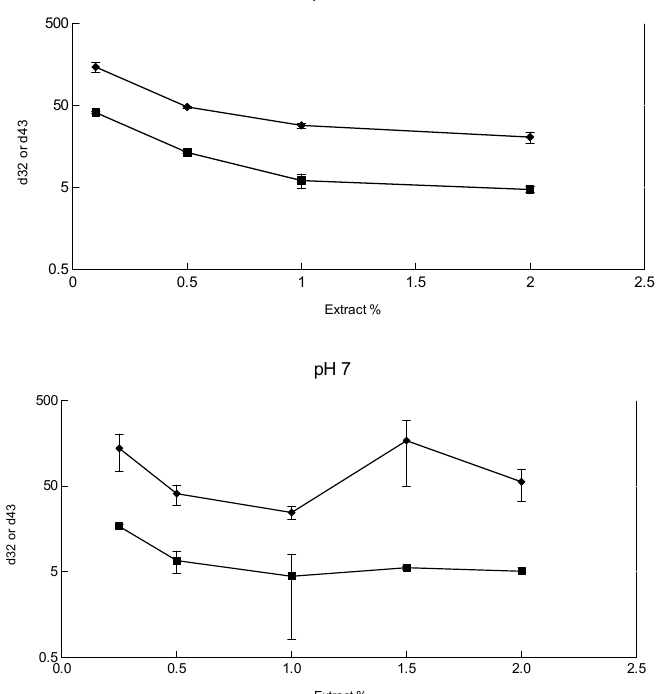
Figure 1. Average diameters d 32 (squares) and d 43 (diamonds) of emulsions stabilized with different concentrations of bean extracts at pH 3 ( top ) and at pH 7 ( bottom ). Increased values of d 43 due to depletion are highlighted (see text).